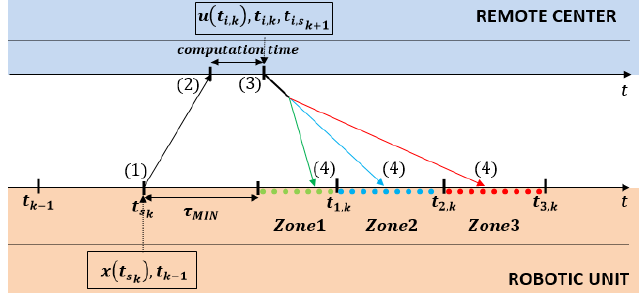
. Case study: L = 3 . i,s k